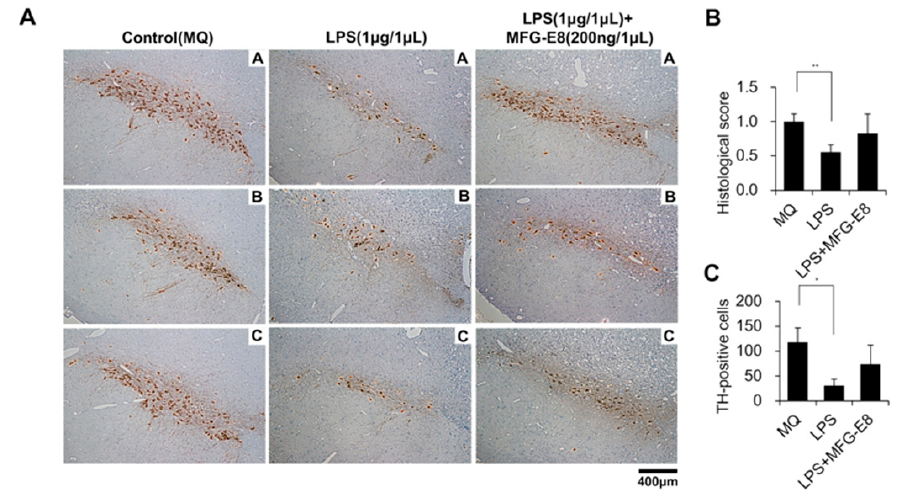
Figure 3. The effect of lipopolysaccharide (LPS) and human MFG-E8 on the dopamine neurons of the substantia nigra. The drug was administered to the rat substantia nigra by manipulation. Brain tissue was harvested at 14 days after administration. A micrograph of the immunohistochemical staining of TH is shown. TH-positive cells, which are stained brown, can be confirmed in the substantia nigra. The left panel shows the tissue sections of 3 rats ( A – C ) treated with control: MQ (1 µ L). The middle panel shows the tissue sections of 3 rats ( A – C ) treated with LPS (1 µ g/1 µ L). The right panel shows the tissue sections of 3 rats ( A – C ) treated with LPS (1 µ g/1 µ L) + human MFG-E8 (200 ng/1 µ L). Scale